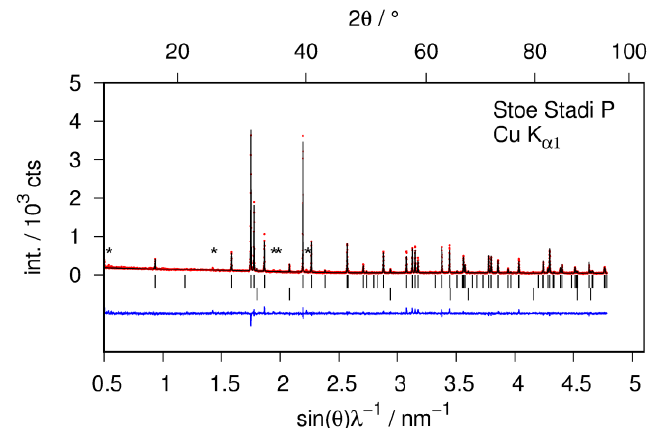
Figure 2. Quantitative phase analysis of the hydrogen-free sample CaSi by Rietveld analysis of X-ray powder diffraction data. Bragg marker: Top row CaSi (98 wt %); bottom row CaO (2 wt %). (*) marks minute intensities of an unidentified impurity phase; red points: observed intensity; black line: calculated intensity; blue line: difference plot.